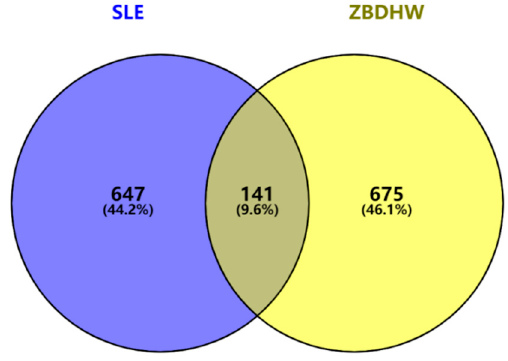
Figure 2. Venn diagram of intersection targets of Zhibai Dihuang pill and SLE.